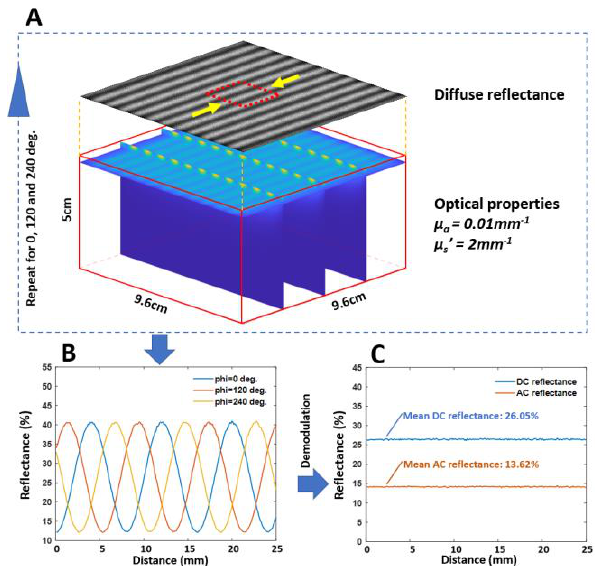
Figure 2. Monte Carlo simulation workflow. ( A ). Schematic of Monte Carlo simulation over a large volume. For each setting, the simulation was performed with phase shifts of 0, 120, and 240 degrees. The central region (red dash box) of the diffuse reflectance image (gray-scale image) was averaged along the direction of yellow arrows to obtain reflectance plots. ( B ). Reflectance plots at three phase shifts. ( C ). Demodulated AC and DC intensity plots.